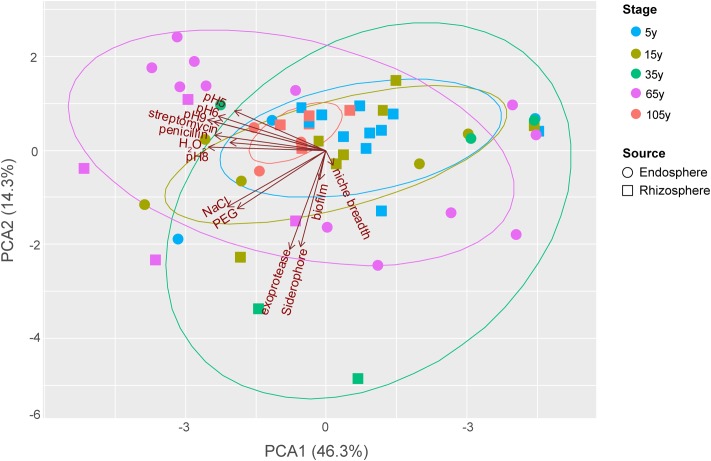
Principal components analysis (PCA) biplot of the functionalities of bacterial isolates from different plant compartments along the chronosequence. For successional stages, blue, light beige, green, purplish red and orange color represent 5, 15, 35, 65 and 105-year stage, respectively. For plant compartments, square refer to rhizosphere isolates whereas circle represent those obtained from the endosphere.